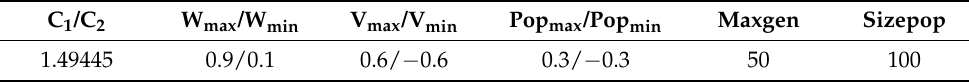
Table 5. The parameters of the particle swarm